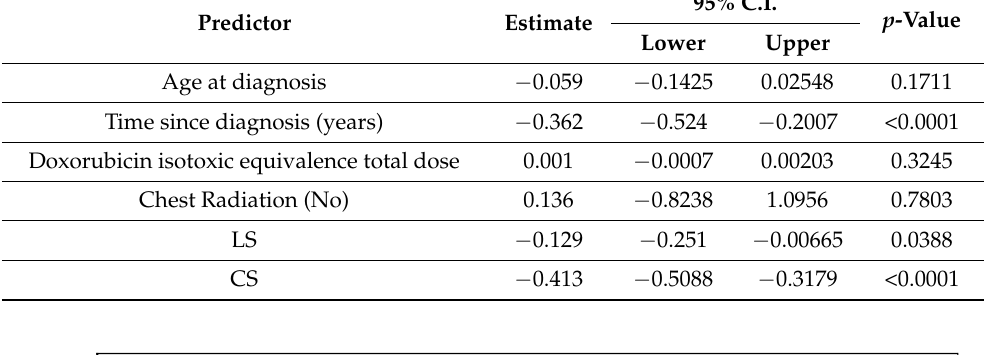
Table 2. Mixed-Effects Model Including All Variables Identified A Priori. Table 2. Mixed-E ff ects Model Including All Variables Identi fi ed A Priori.